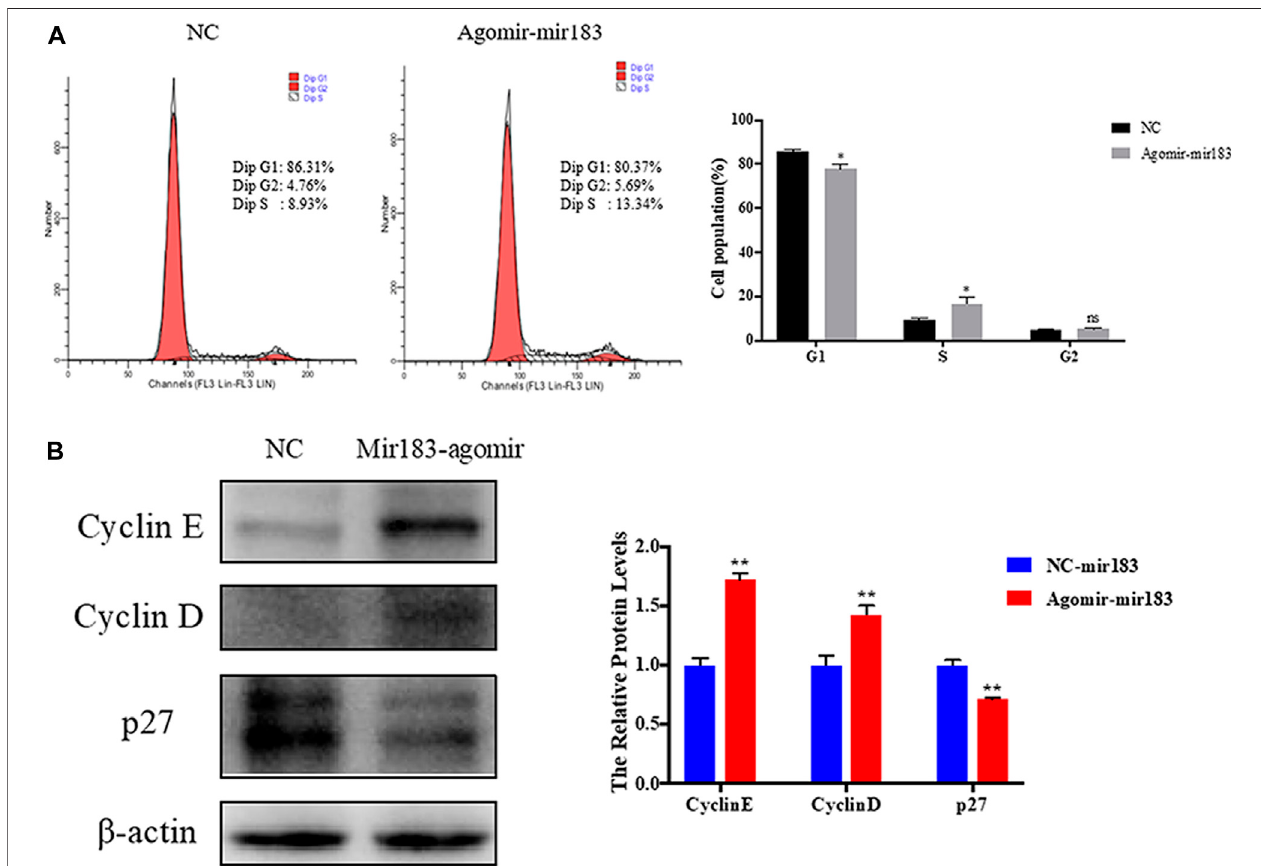
FIGURE 7 | Regulation of miR-183 in cell cycle of granulosa cells. (A) The cell cycle of granulosa cells after transfection of miR-183; (B) Cyclin E, Cyclin D and p27 protein expression and quanti fi cation. β -actin protein was used as an internal reference.